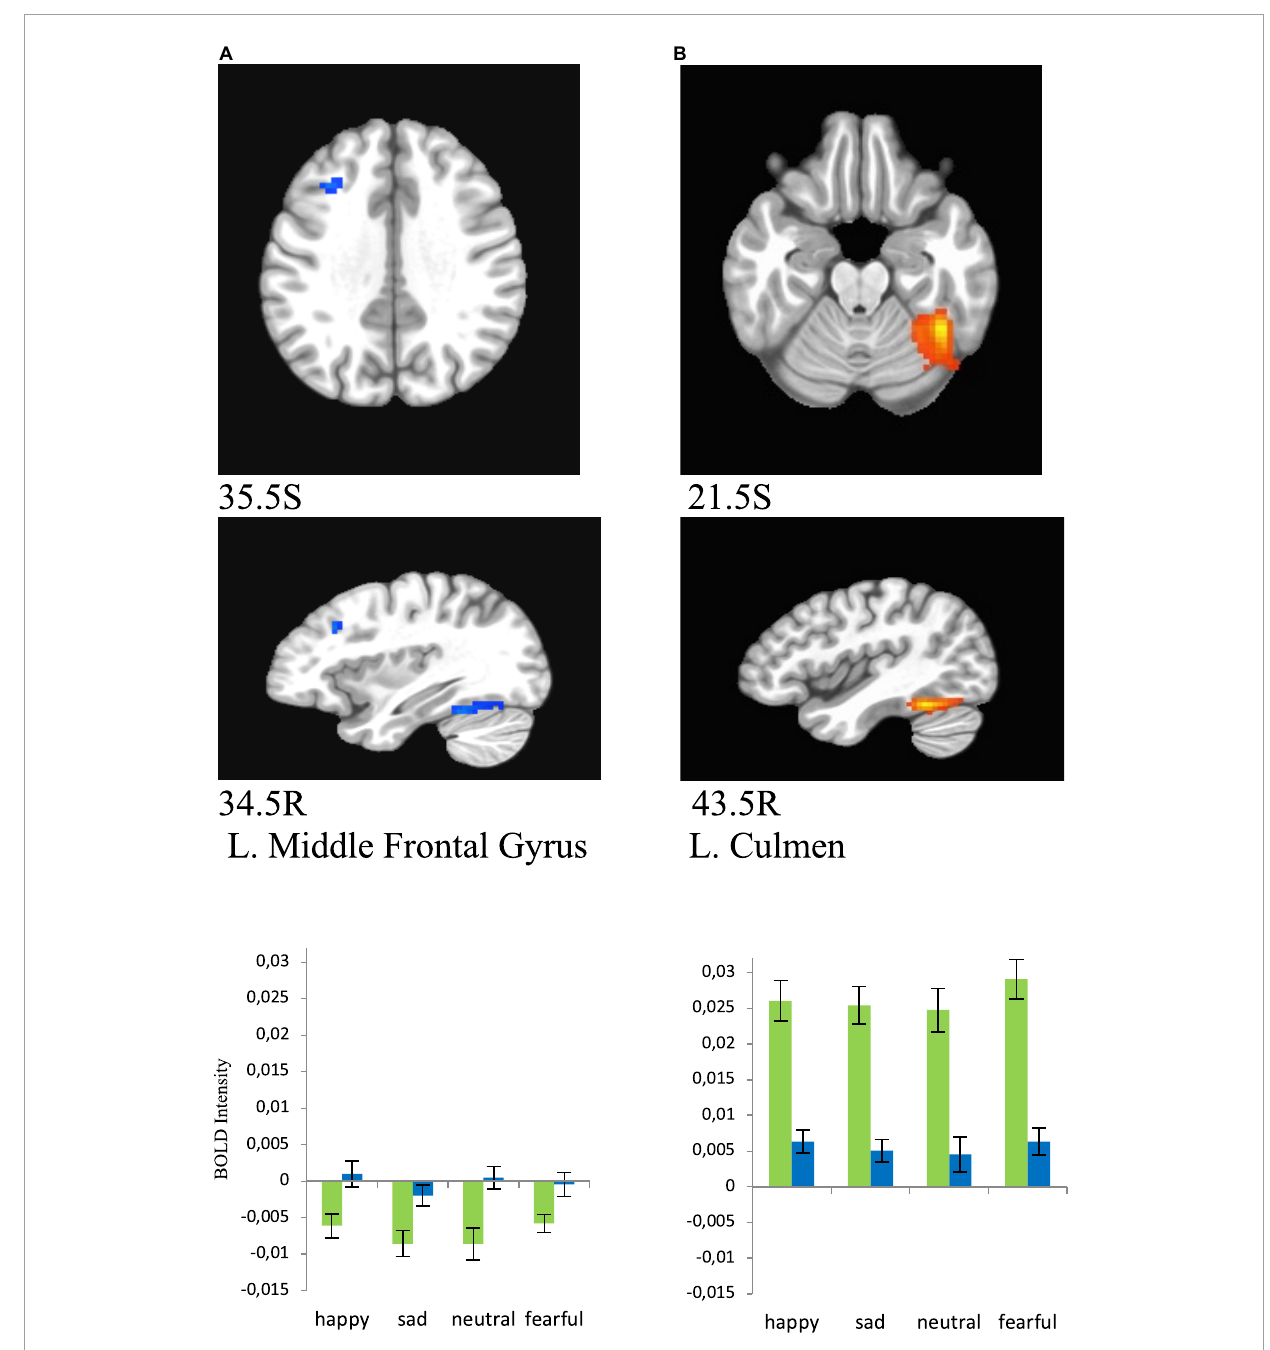
FIGURE6 Brain regions that showed significant sex effect in MDD participants for presentations of happy, sad, fearful, and neutral faces [females – green color, males – blue color; (A) left middle frontal gyrus/BA8 men > women, (B) left culmen women > men]. BOLD intensity during happy, sad, neutral, and fearful faces perception in MDD groups for females and males in panels (A,B) brain areas ( p <